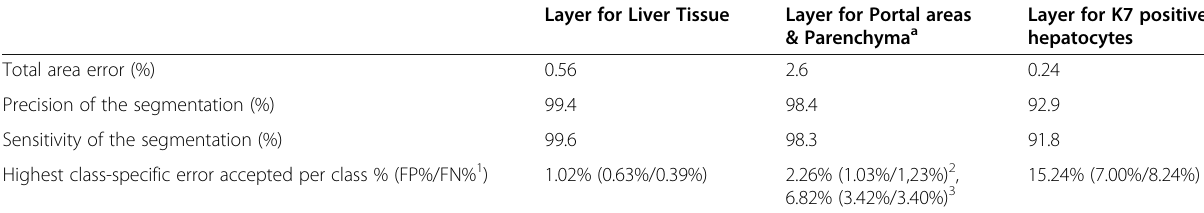
Table 3 Total area errors, precisions and sensitivities per each layer. Since there are two classes in the portal areas and parenchymal layer, highest class-specific errors have been evaluated for both classes. Total area errors are the sum of false positive (FP) and false negative (FN), namely the total errors per training areas in each layer of the AI model Layer for Liver Tissue Layer for Portal areas Layer for K7 positive & Parenchyma a hepatocytes Total area error (%) 0.56 2.6 0.24 Precision of the segmentation (%) 99.4 98.4 92.9 Sensitivity of the segmentation (%) 99.6 98.3 91.8 Highest class-specific error accepted per class % (FP%/FN% 1